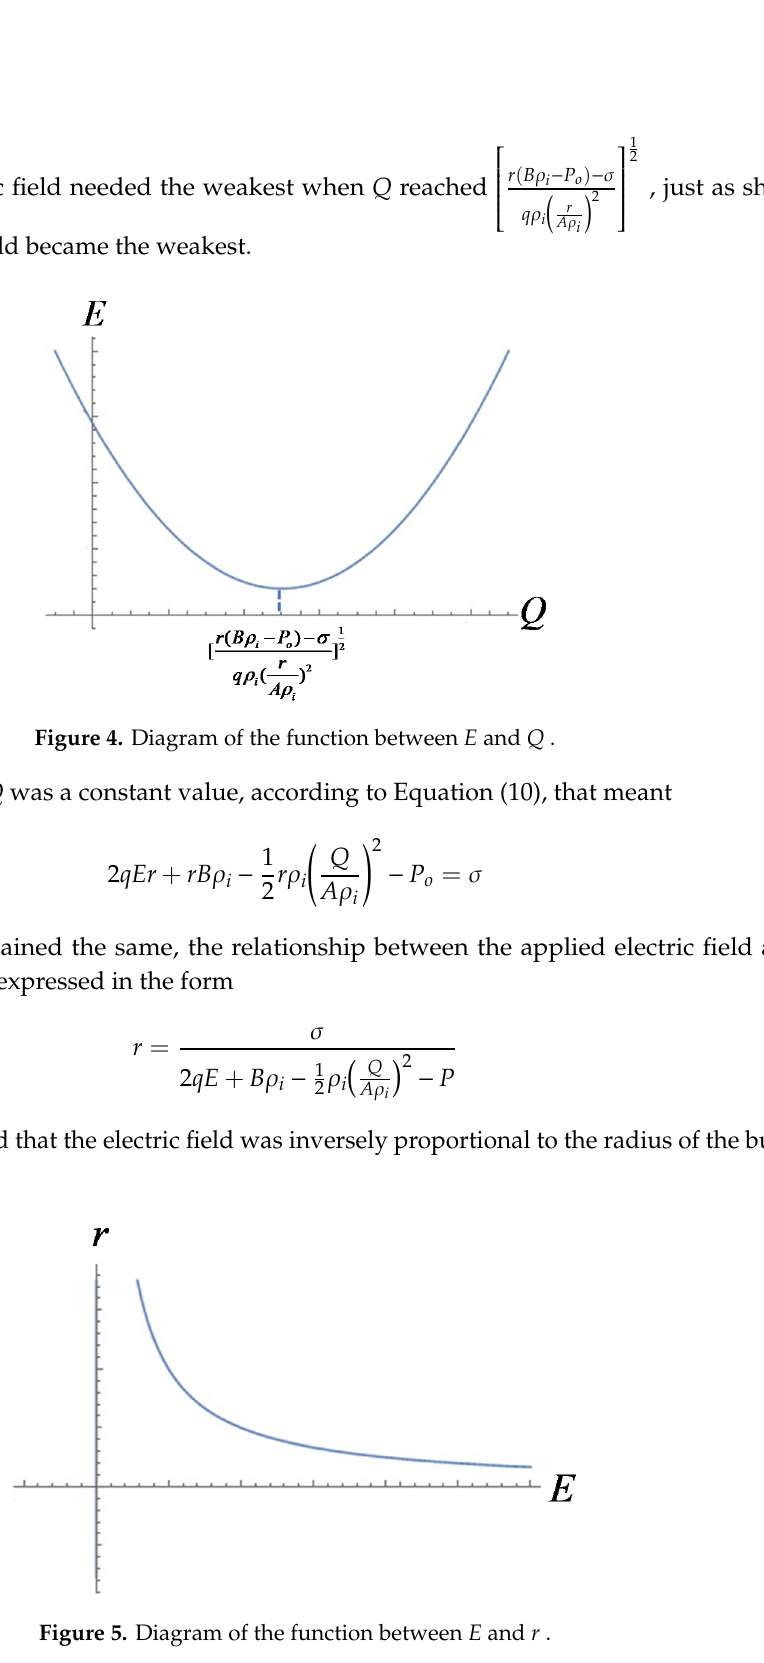
Figure 5. Diagram of the function between 𝐸 and 𝑟 .